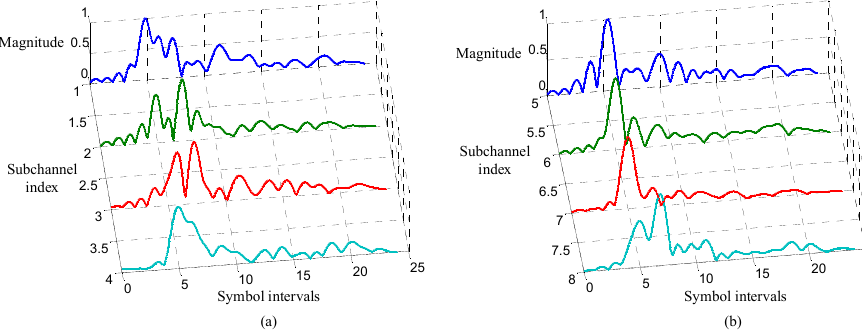
Figure 9. Subchannel responses: ( a ) responses of the first four subchannels; ( b ) responses of the last four subchannels.